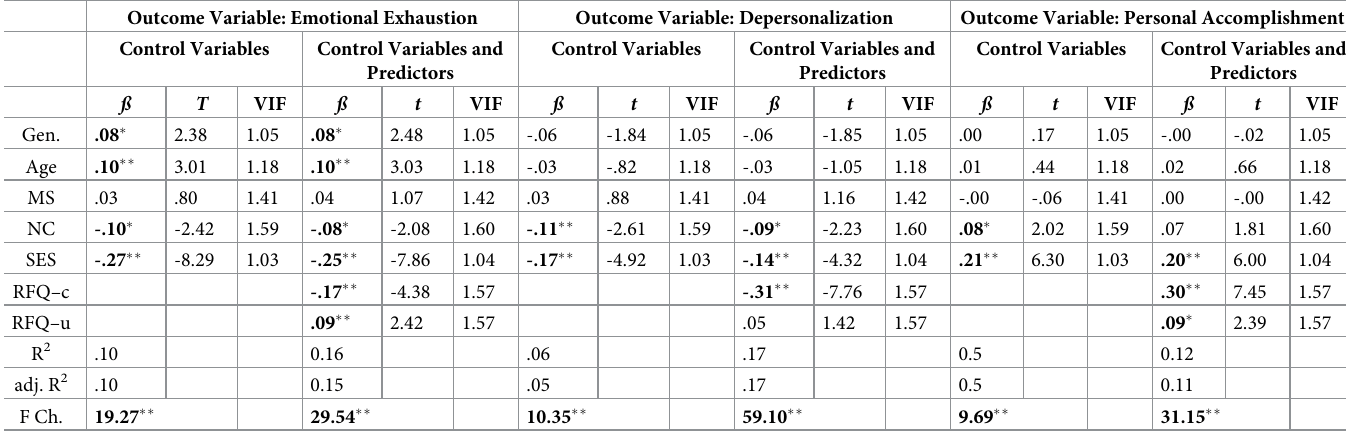
Table 3. Hierarchical linear regression analysis of the relationship among teachers’ burnout dimensions and